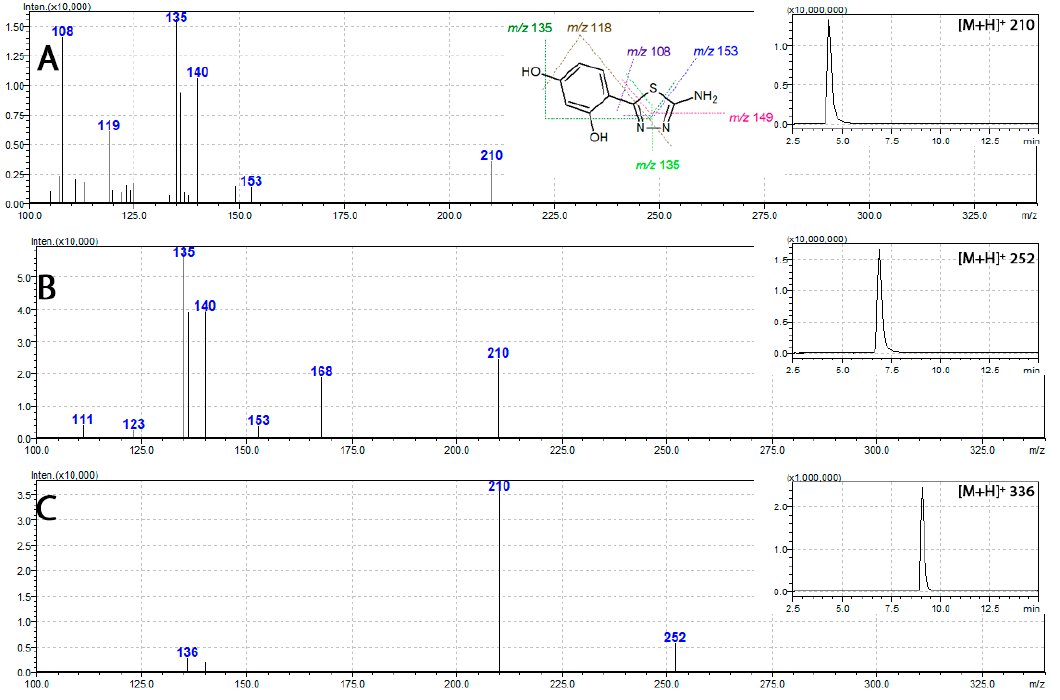
Figure 4. Mass spectra of thiadiazole derivatives 1 , 2 , and 3 ( A , B , and C , respectively) together with their respective mass chromatograms (insets).